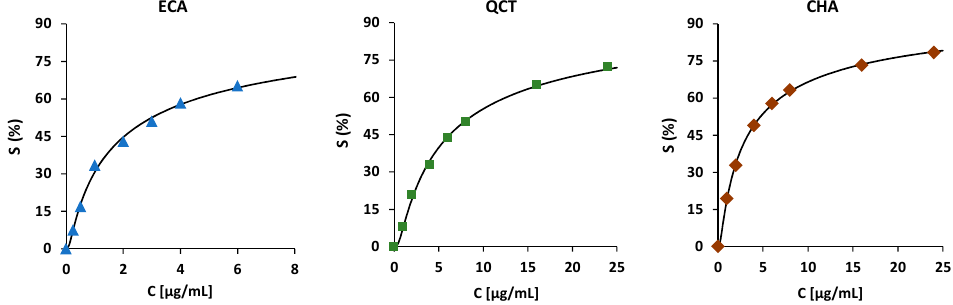
Figure 4. Observed mean data ( n = 5) and the fitted dose-response curves for the main extracts’ constituents in the O 2 •– scavenging capacity assay. Table 3. Estimated model parameters for the dose-response curves of the main extracts’ constituents in the O 2 •– scavenging capacity assay according to Equation (2).